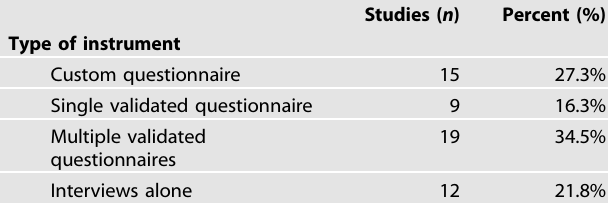
Table 2. Methods used in included